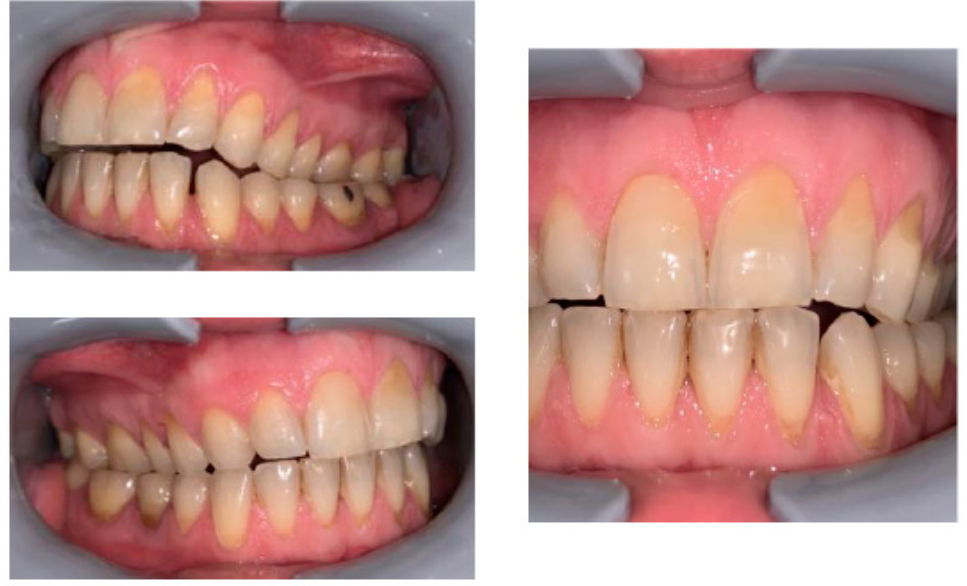
Figure 3. Occlusal relationships.